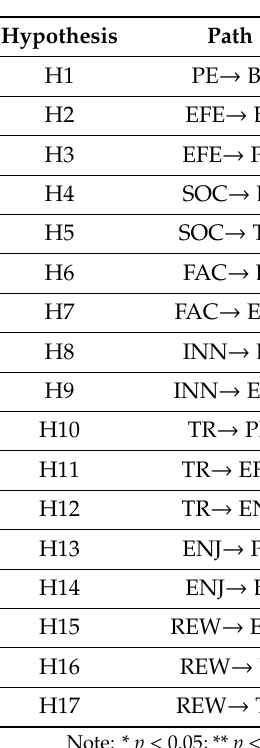
Table 7. Path coe ffi cients (standardized regression coe ffi